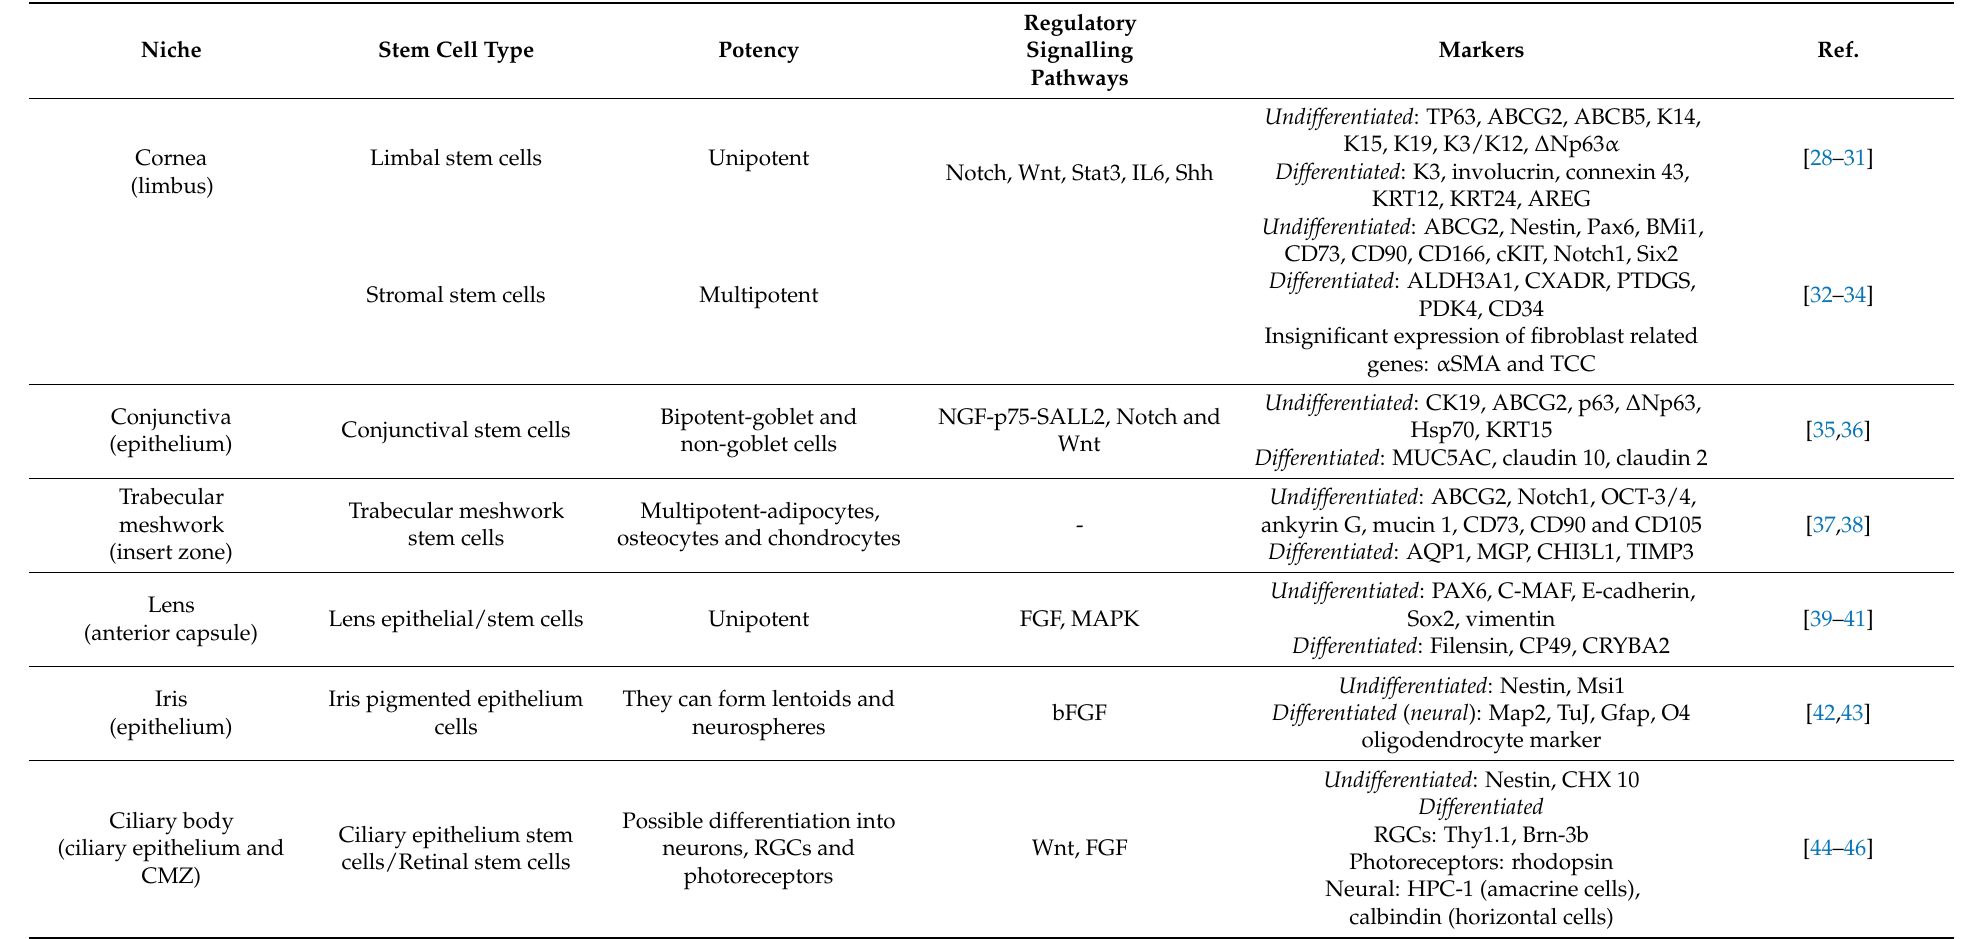
Table 1. Characteristics of the adult stem cells that populate the different stem cell niches in the anterior segment of the